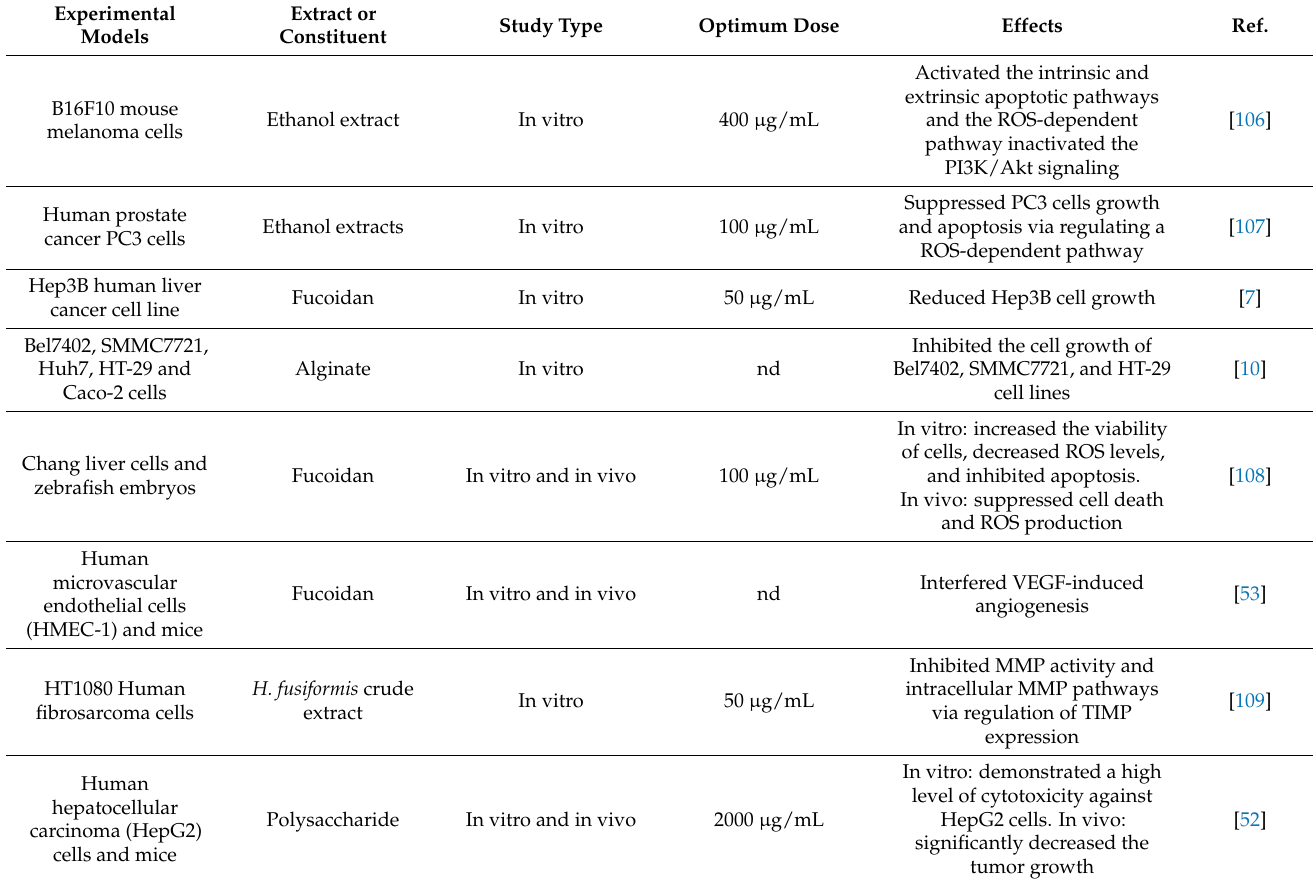
Table 7. Summary of the anticancer and antitumor activities of H. fusiformis